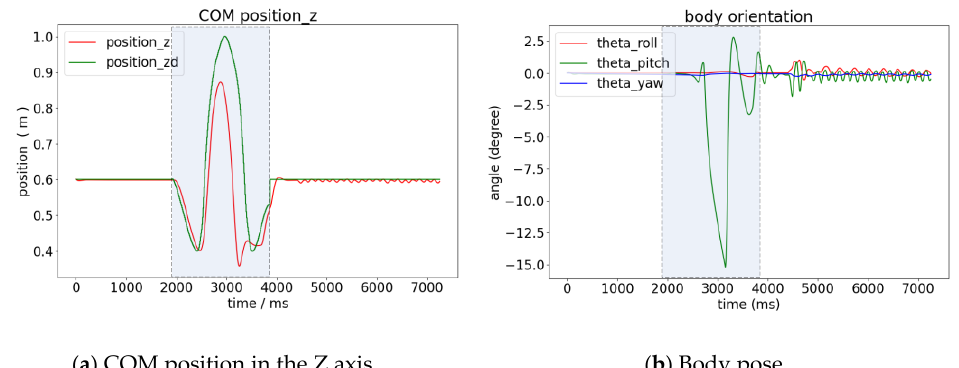
( a ) COM position in the Z axis. ( b ) Body pose.